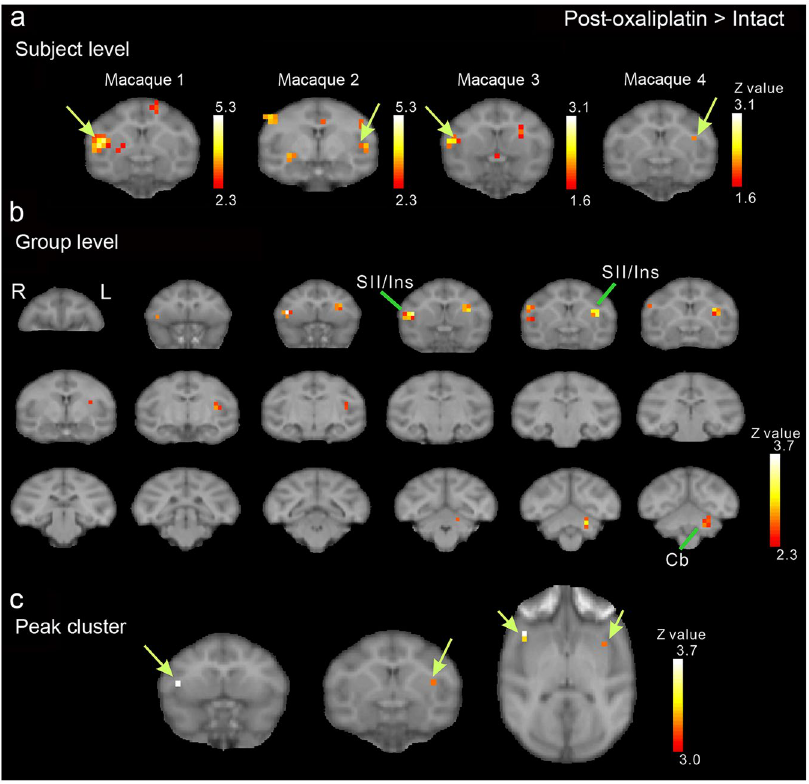
Figure 3. Brain activity changes associated with oxaliplatin-induced cold hypersensitivity. Three days after oxaliplatin infusion, increased activation in the secondary somatosensory cortex (SII) and the insular cortex (Ins) in both hemispheres, compared with activation before oxaliplatin infusion (“Intact”) (c.f. Table 1), were associated with low-temperature stimulation (i.e., activity in response to 10 °C stimulation minus activity in response to 37 °C (control) stimulation). ( a ) Results of subject-level analysis. Increased activation in SII/Ins (arrows) is observed in all four oxaliplatin-treated macaques. ( b ) Results of group-level analysis. A series of coronal slices, spaced 2 mm apart, are arranged from rostral (upper left, y = 24) to caudal (lower right, y = − 10). Cb, cerebellum. ( c ) Peak voxels were located in the anterior SII/Ins of both hemispheres (arrows). The arrows indicate peak voxels in each